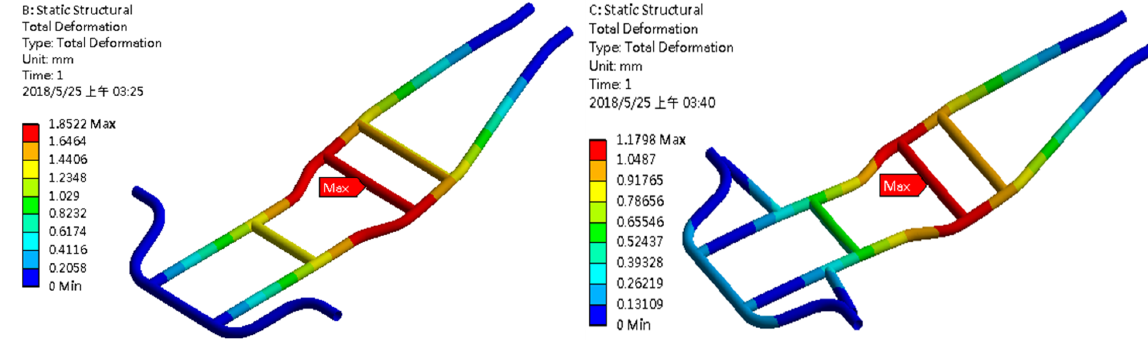
Figure 32. Bending rigidity analysis of the frame (with/without stiffeners).